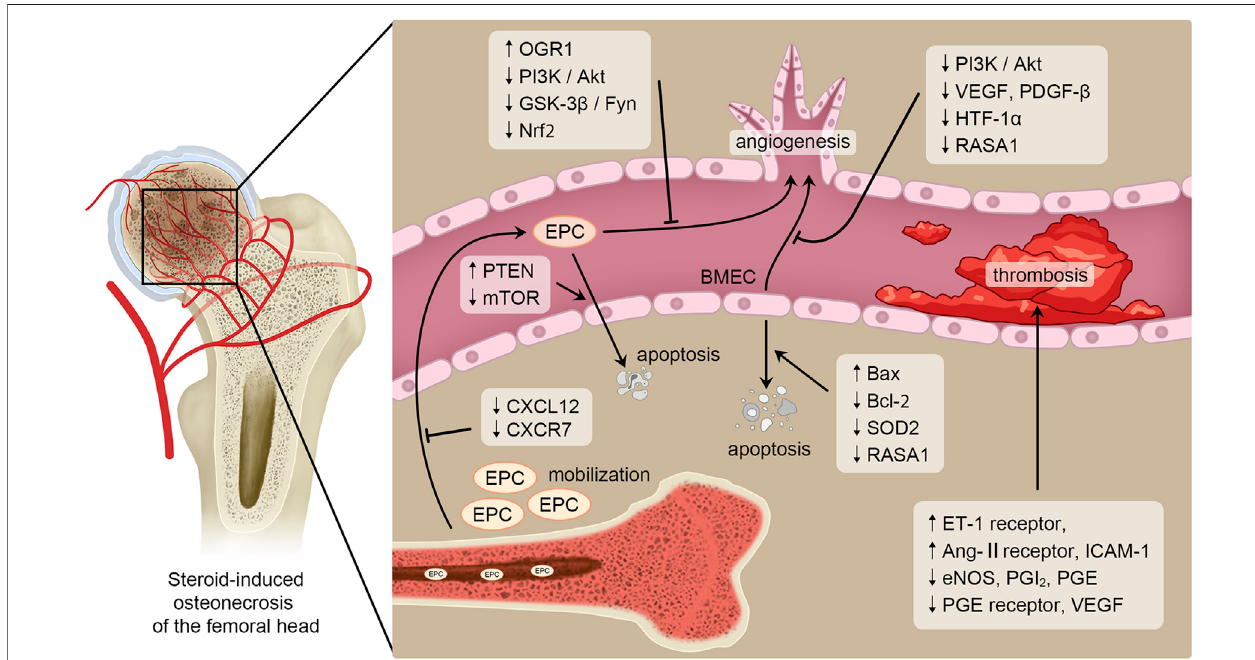
FIGURE 1 | Pathogenesis in SONFH related to bone endothelial cells. Blood vessels play a critical role in the occurrence and progression of SONFH. And bone endothelial cells are essential for maintaining vascular homeostasis and angiogenesis. Therefore, bone endothelial cells are key regulatory factors in the pathogenesis of SONFH. SONFH is affected by GCs regulating mobilization, angiogenesis, apoptosis and thrombosis of bone endothelial cells through several signaling pathways or cytokines such as PI3K/Akt, GSK-3 β /Fyn, Bcl-2 and Bax.